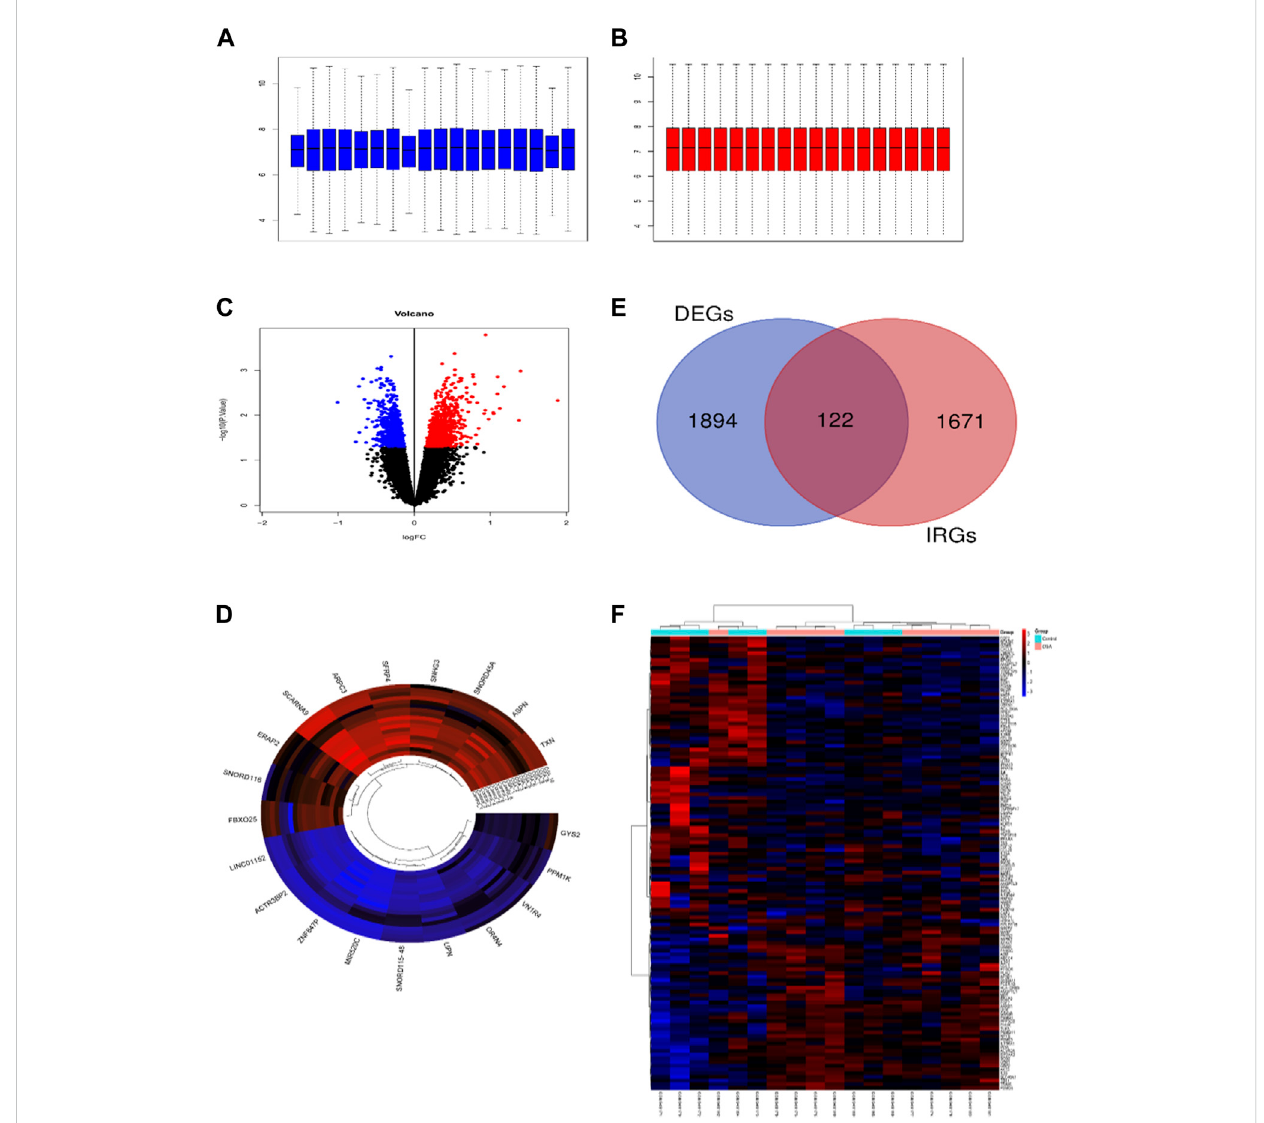
FIGURE 1 Identi fi cation of immune-related differentially expressed genes (IRDEGs). Box plots show the distribution of the relative gene expression before (A) and after (B) normalization of GSE38792. Each box corresponds to one sample. The middle line corresponds to the median. (C) Volcano plot of differentially expressed genes (DEGs). DEGs were screened with the criteria of p-value < 0.05. (D) The cluster circular heat map showing the top 10upregulatedanddownregulatedDEGs. (E) VenndiagramshowingtheintersectionofDEGsandimmune-relatedgenes(IRGs). (F) Theheatmapof 122